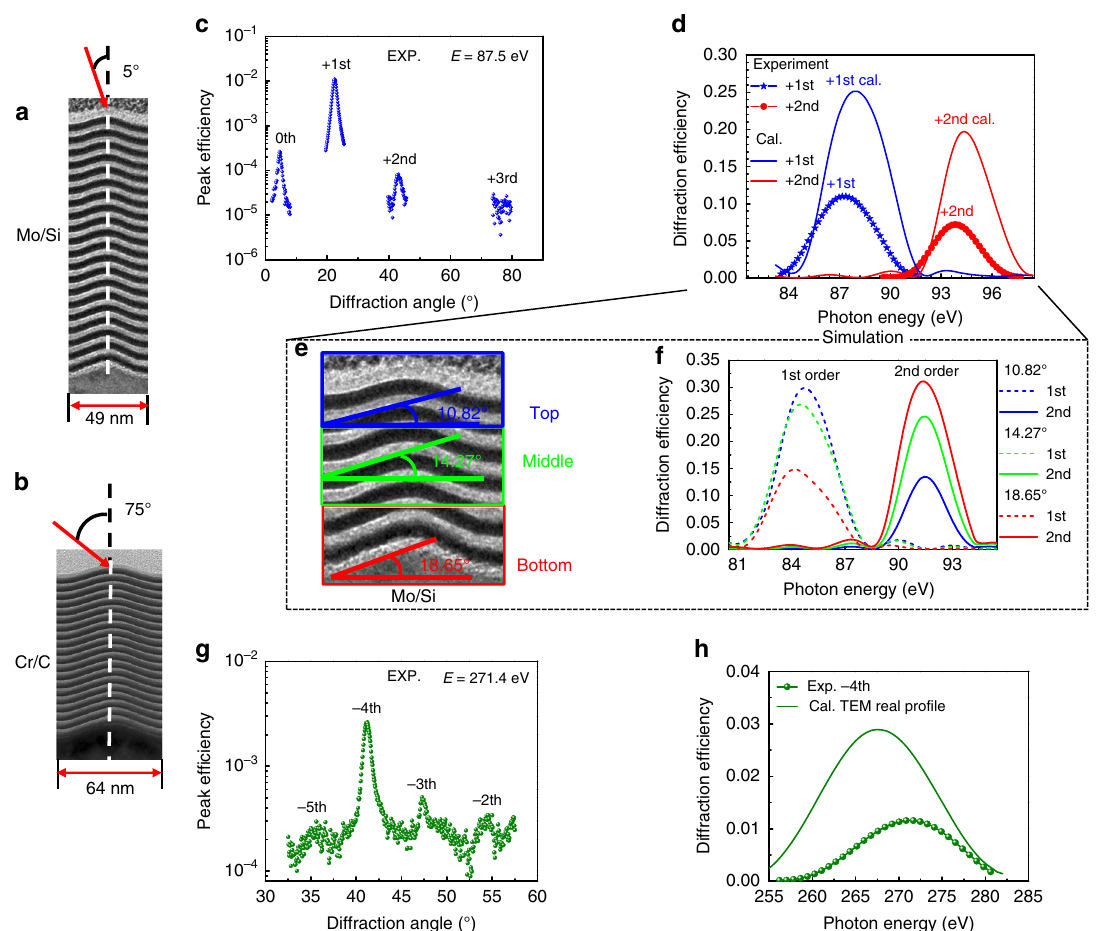
Fig. 3 EUV and soft X-ray measurements of the nanogratings. Schematic of the Mo/Si ( a ) and Cr/C ( b ) MBGs working at incident angles of 5° and 75°, respectively. Ef fi ciency distribution (detector scan) of the Mo/Si ( c ) and Cr/C ( g ) MBGs were measured at a photon energy of 87.5 eV and 271.4eV, respectively. The experimental (stars and circles) and simulated (solid lines) curves of the integral diffraction ef fi ciency of the 1st (blue lines) and 2nd (red lines) orders of Mo/Si MBG are shown in ( d ). The experimental (spheres) and simulated (solid lines) curves of the integral diffraction ef fi ciency of the − 4th order of Cr/C MBG is shown in ( h ). The simulations in ( d ) and ( h ) were performed with the real structures derived from the XTEM images shown in ( a , b ). The local groove pro fi les at the top, middle, and bottom positions of the Mo/Si BMG stack are shown in ( e ) and the simulated ef fi ciency of the 1st and 2nd orders of Mo/Si BMGs using the three different groove pro fi les are shown in ( f